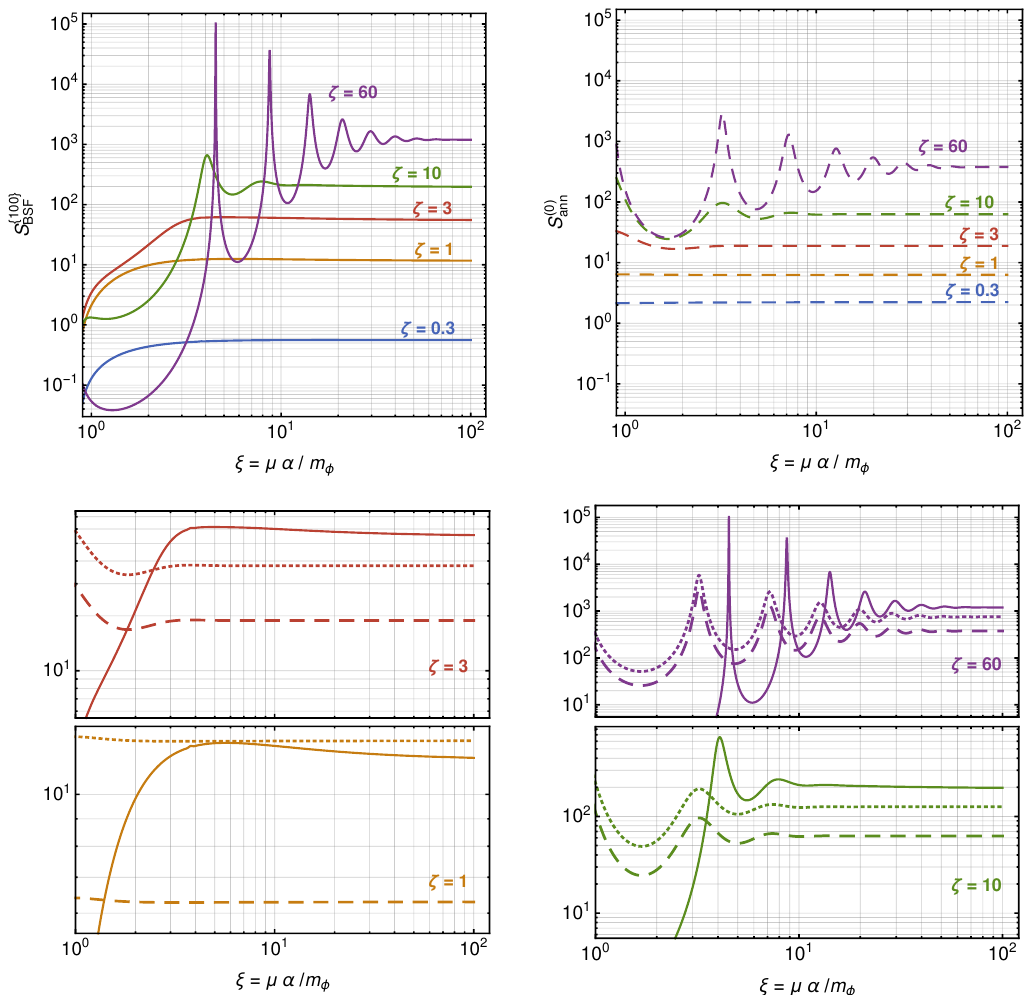
Figure 3a . Resonances due to bound states at threshold (zero binding energy) appear at discrete values of (cid:24) = (cid:22)(cid:11)=m ’ , with a magnitude that increases at low energies (large (cid:16) = (cid:11)=v rel ). They arise from the wavefunction of the (initial) two-particle scattering state, and depend on the ‘ modes that contribute to the process of interest. Top left: the factor S f 100 g in the cross-section for capture into the ground state, with emission of a vector force mediator.